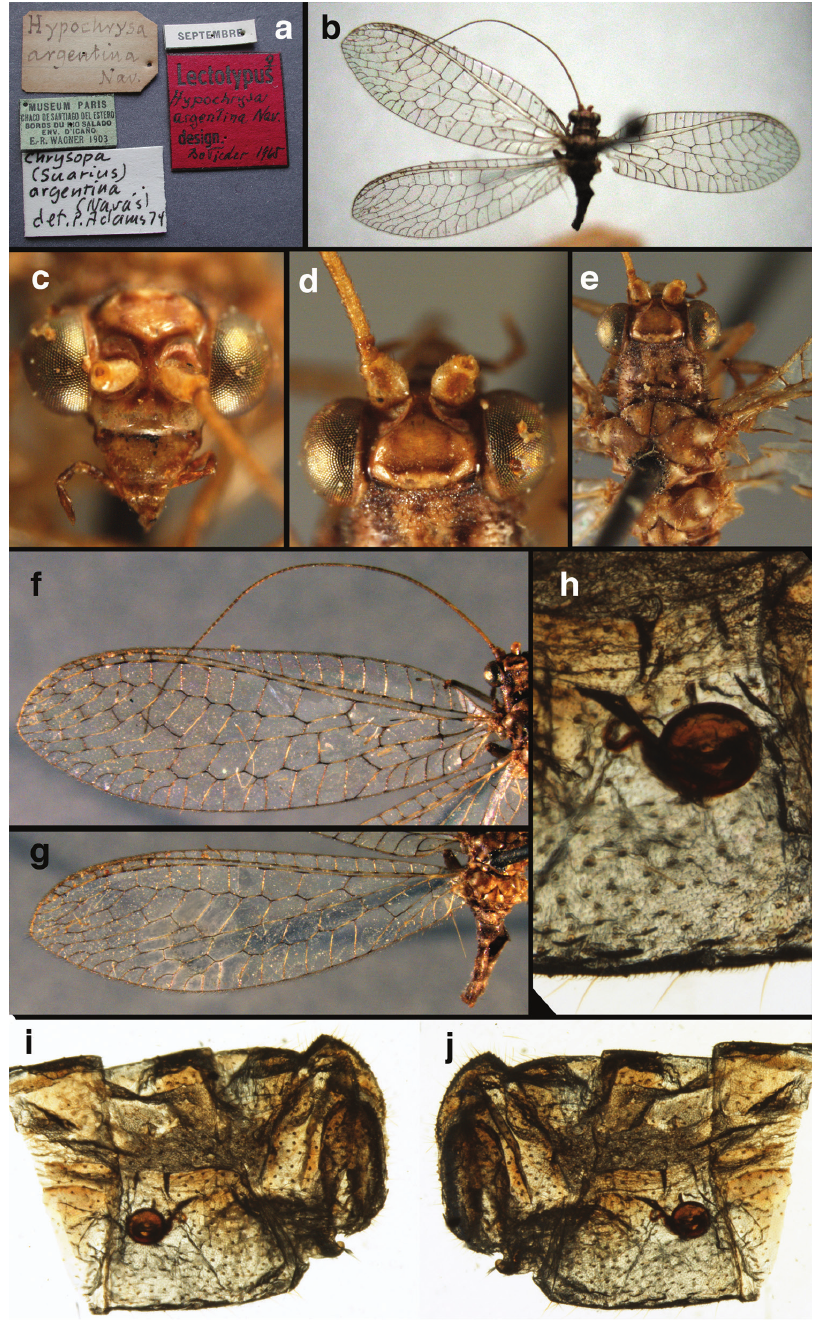
Figure 102. Ungla argentina (Navás): Features, ( a ) labels ( b ) habitus, dorsum ( c ) head, frontal ( d ) head, dorsal ( e ) head, thorax, dorsal ( f ) forewing ( g ) hindwing ( h ) spermatheca ( i, j ) terminalia, left, right (Argentina, Santiago del Estero, lectotype, female,